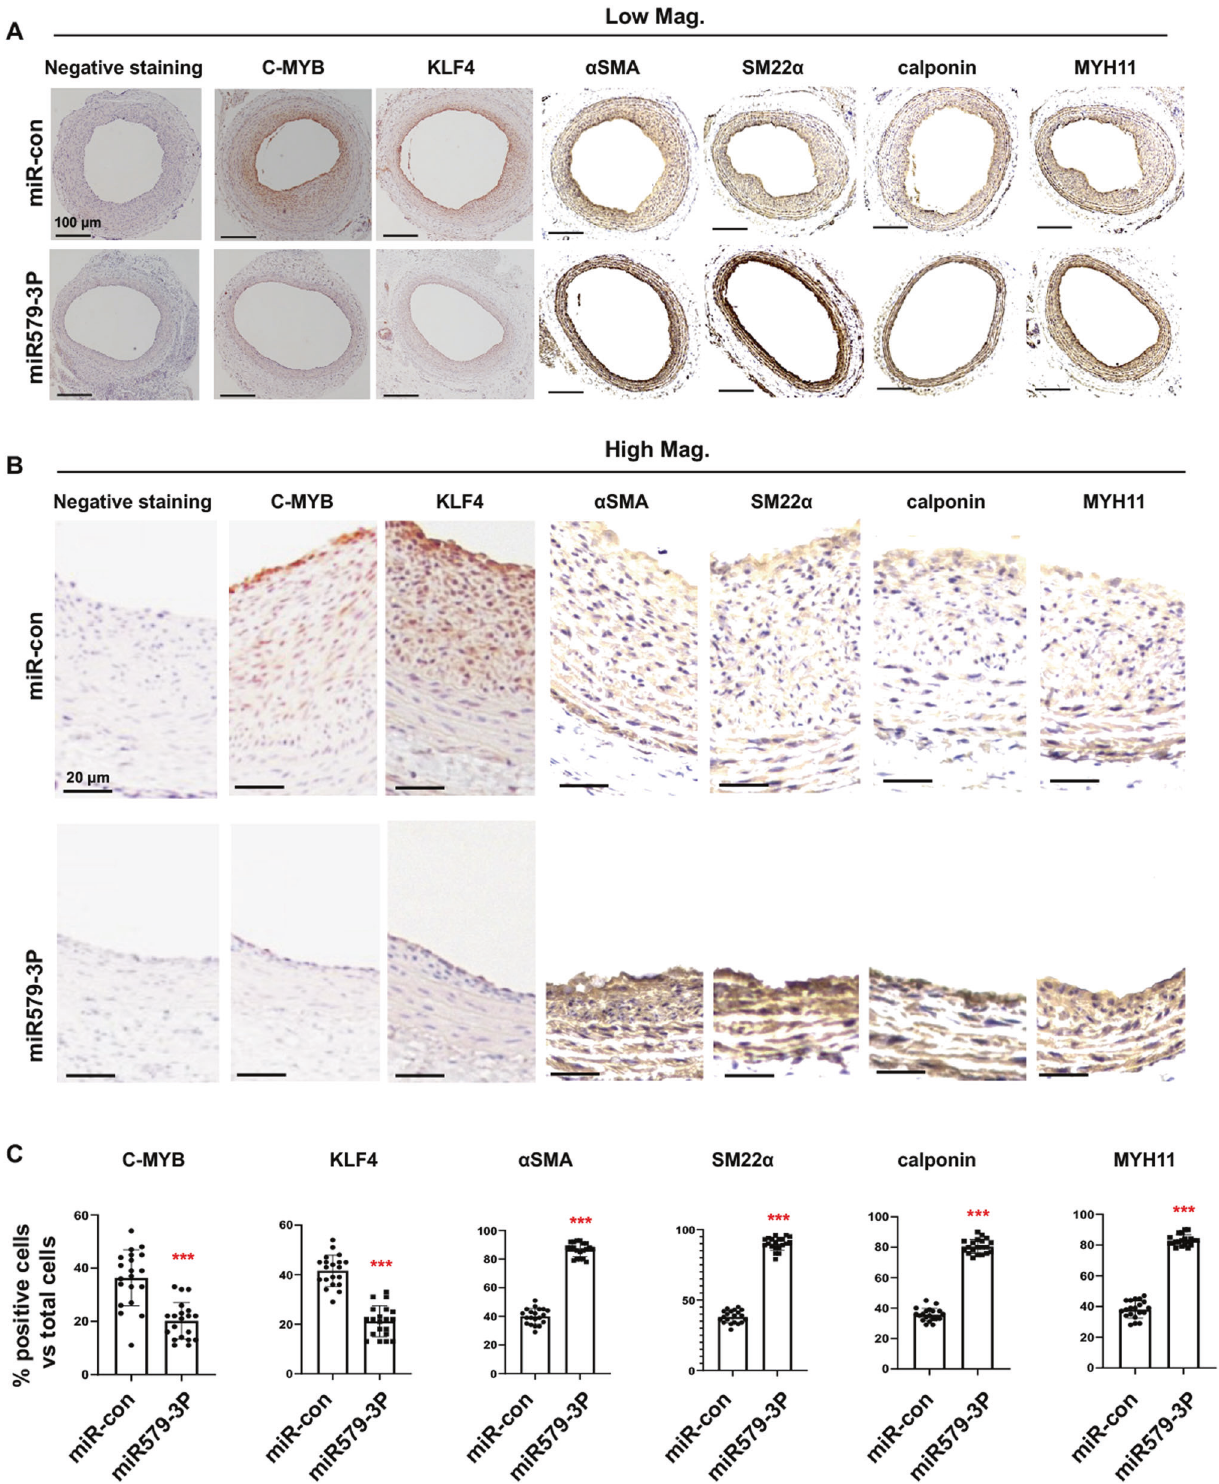
Fig. 6 Treatment of injured rat carotid arteries with the miR579-3p lentivirus reduces c-MYB and KLF4 expression and increases SMC contractile proteins. The lentivirus for expressing miR579-3p or miR-Con was infused into the rat carotid artery wall immediately after balloon injury. The arteries were collected 14 days after injury and immunohistochemistry was performed on cross-sections to detect c-MYB, KLF4, α SMA, SM22, Calponin, and MYH11. A , B Representative immunostained cross ‐ sections (low-mag and high-mag, respectively). Negative staining: no primary antibody. Scale bar: 100 μ m for low-mag pictures and 20 μ m for high-mag pictures. C Quanti fi cation. Three sections were used for each animal, and the data values (colorimetric intensity per image fi eld) from total 7 rats in a treatment group were averaged; mean ± SD ( n = 20 or 21 sections). Statistics: Unpaired Student ’ s t -test; * P < 0.05, ** P < 0.01, *** P < 0.001.